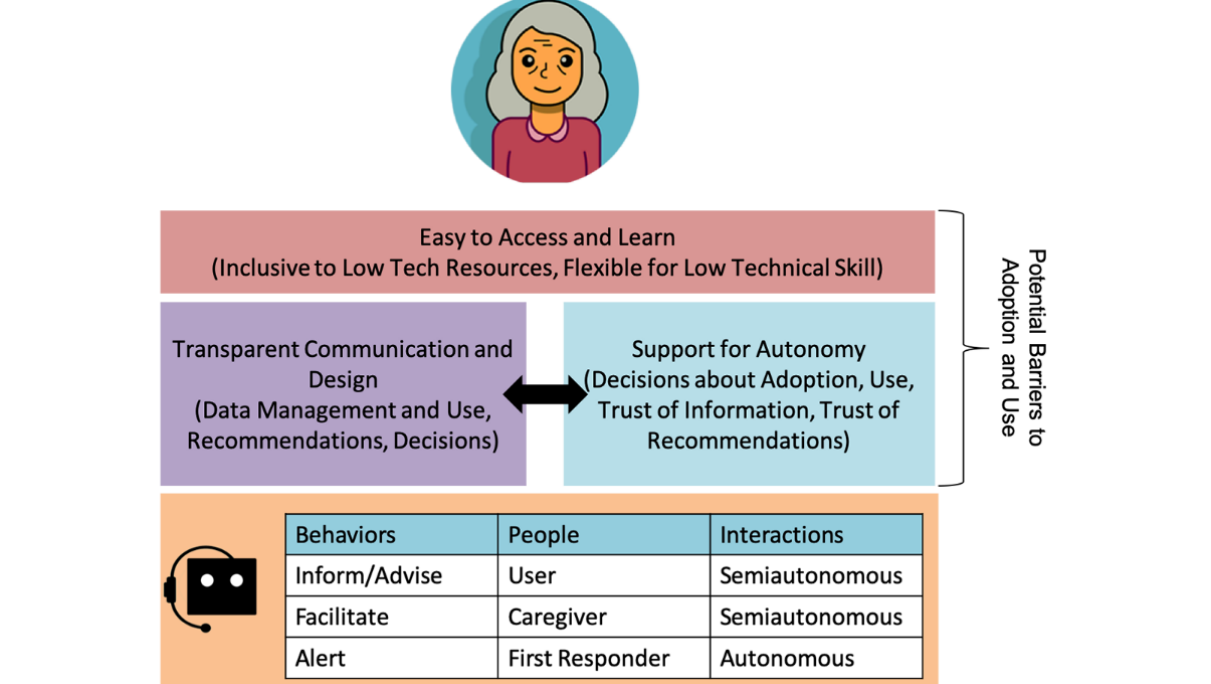
Figure 3. Model of participants' desired interactions with intelligent assistants for health information management and